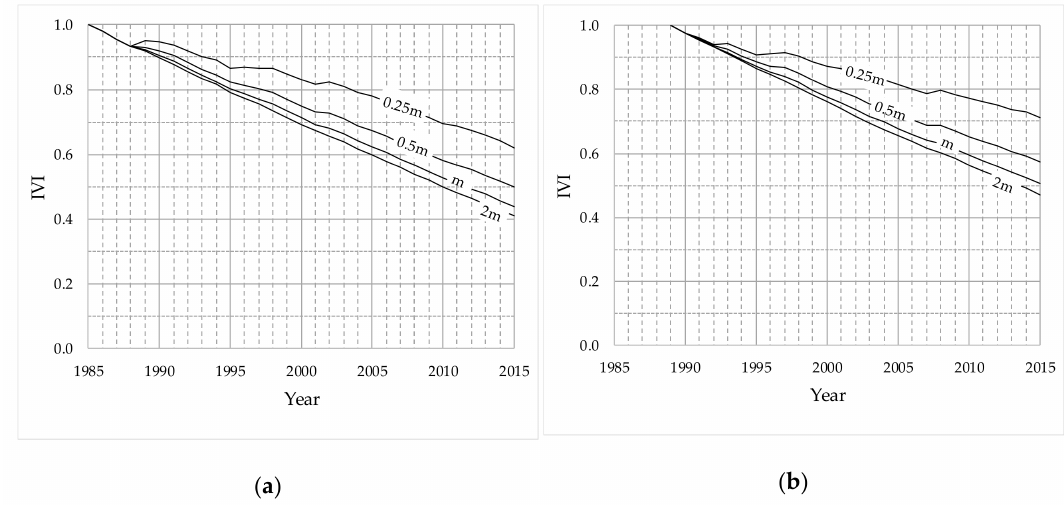
Figure 9. Sensitivity analysis of IVI index: ( a ) Asset 1; ( b ) Asset